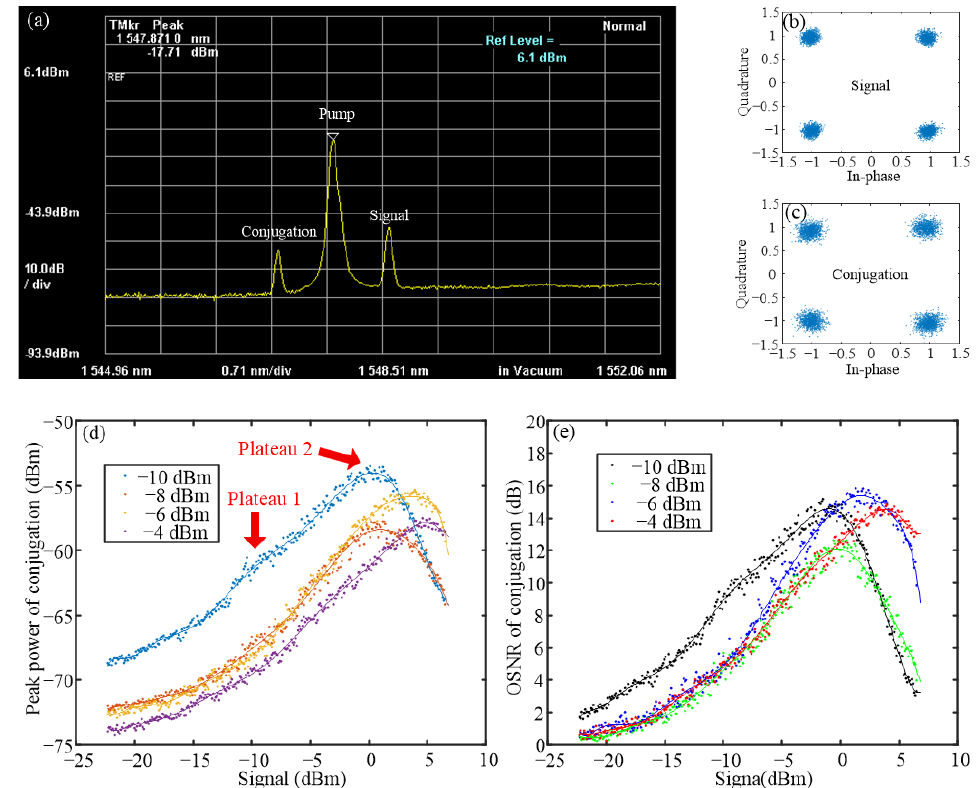
Figure 9. The result of the experiment in YB case; ( a ) spectrum; constellation results of input signal ( b ) and the conjugated signal ( c ); ( d ) power transfer function; ( e ) OSNR curve. (dots: experimental data; solid: fitting curve).